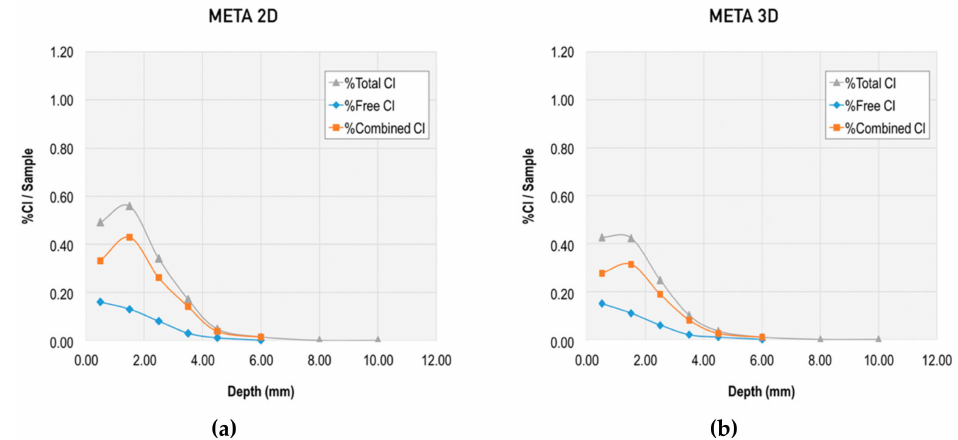
Figure 7. Total, free, and combined chloride content in META mix at early ages: ( a ) at two days and ( b ) at three